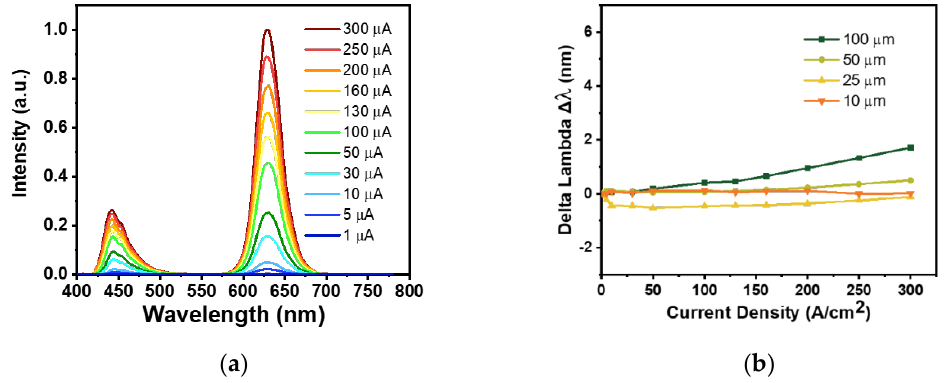
Figure 10. Electroluminescence spectra of ( a ) 10 × 10 µ m 2 QD red micro-LED at various forward currents; ( b ) EL shift as a function of current density for different red QD micro-LED